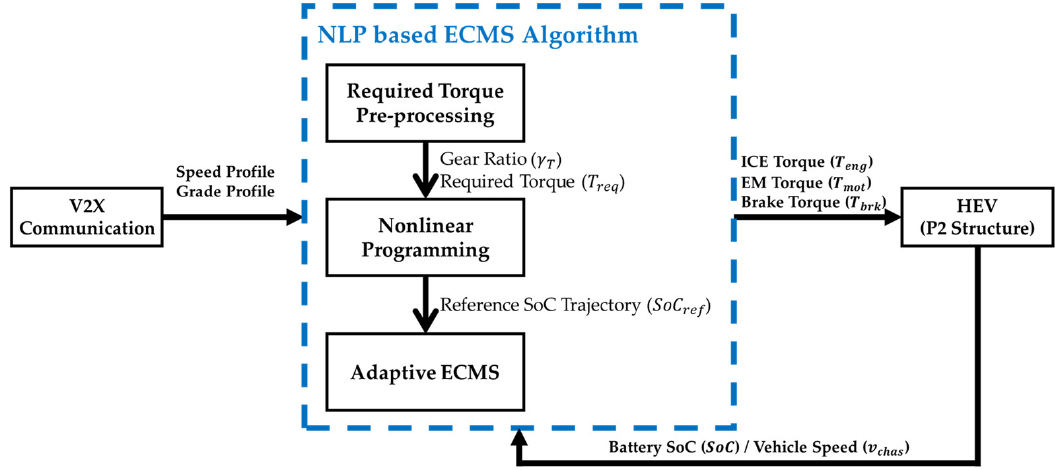
Figure 4. Conceptual diagram of the NLP-based ECMS algorithm.